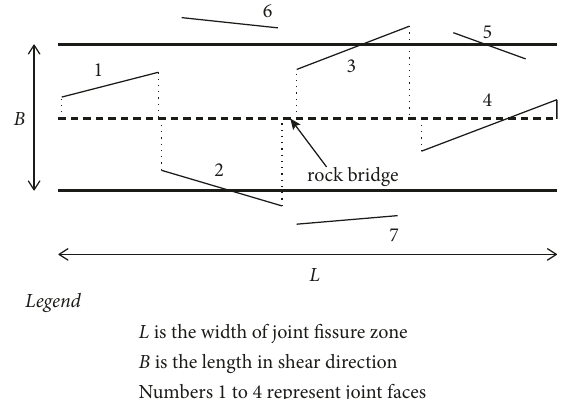
Figure 1: Principle of the bandwidth projection method.